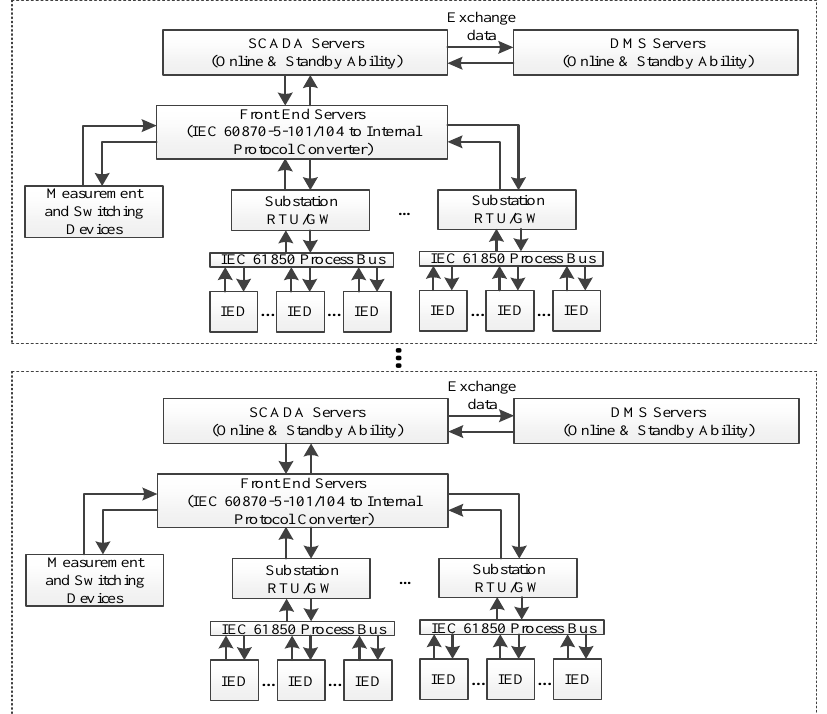
Figure 2. De-centralized architecture of DMS for distribution network.